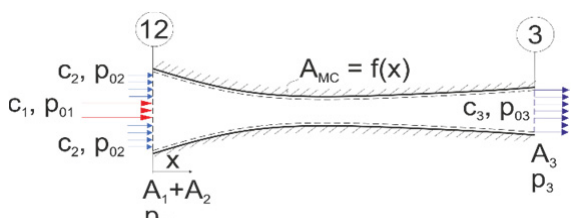
Fig. 2. Control volume of a mixing chamber of general